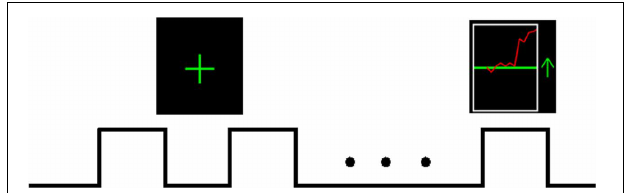
FIGURE 1 | Outline of one rtfMRI training session. Each session lasted 450s, during which time 30-s blocks of rest alternated with 30-s blocks of motor imagery with feedback, for a total of seven task blocks and eight rest blocks. During the rest blocks, green “ + ” sign was presented on the screen; and during the task blocks, the green up arrow appeared on the screen along with the continually updated red